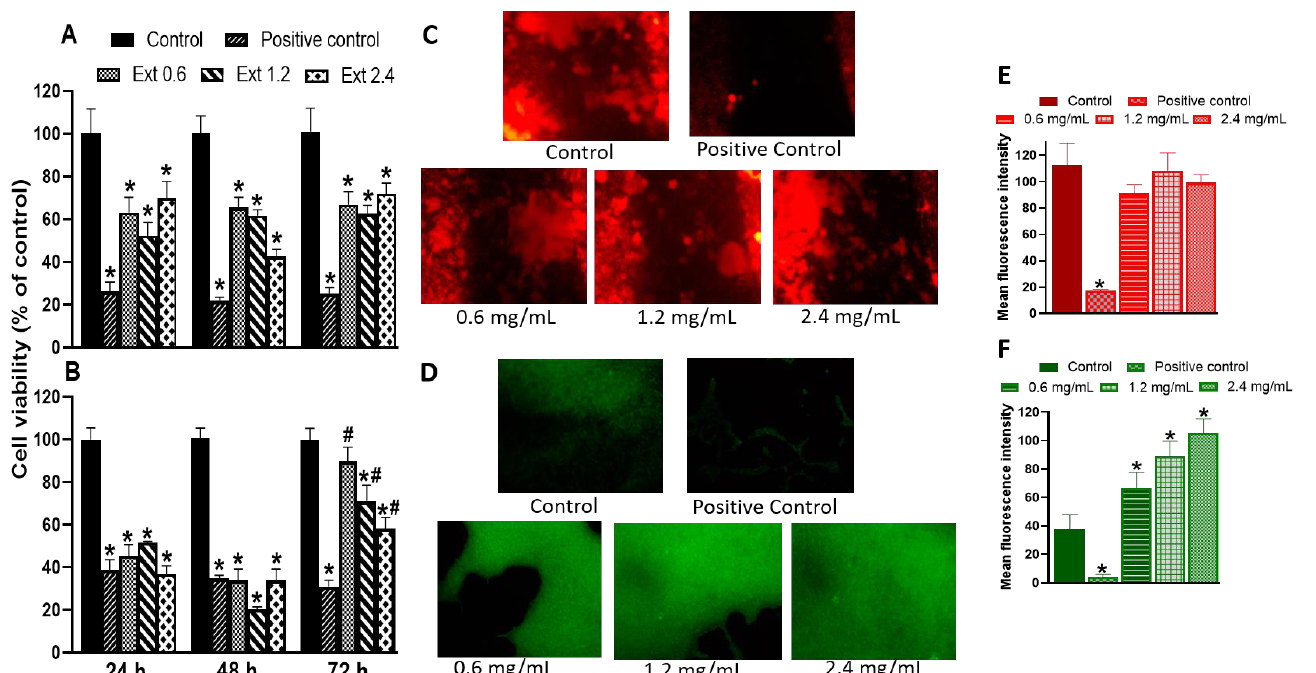
Figure 4. Effect of E. hyemale extract (Ext: 0.6, 1.2, and 2.4 mg/mL) on the viability of RAW 264.7 cells ( A ) and porcine skin fibroblasts ( B ) after 24, 48, and 72 h of treatment. ( C , D ) Representative micro- graphs of the proliferation assay of RAW 264.7 cells and skin fibroblasts stained with rhodamine B and fluorescein, respectively. ( E , F ) Quantification of fluorescence signal in RAW 264.7 cells and fi- broblasts, respectively. Positive control corresponds to the cell treatment with triton X-100 (1%). * p < 0.05 versus control (DMEM), # p < 0.05 versus the same concentration at 24 and 48 h.